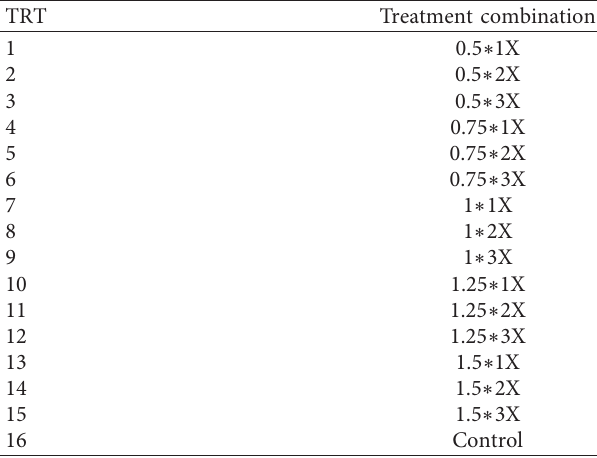
Table 1: Treatment combination of five propiconazole rates and three spraying